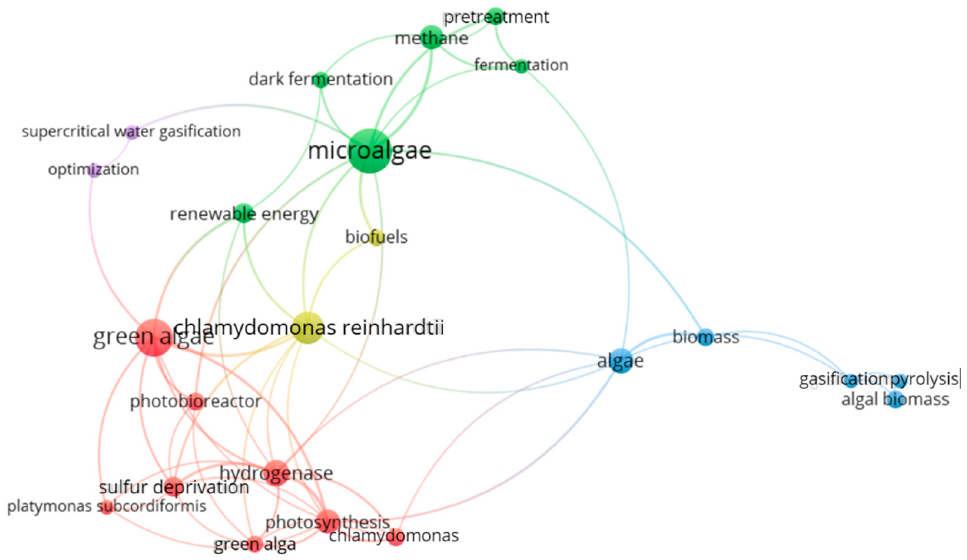
Figure 4. The network map for the top keywords is subdivided into four clusters based on the similarities. Keywords related to bioH 2 were removed. (The size of the node represents the frequency of occurrence, and the curved lines show the co-appearance between the keywords.)